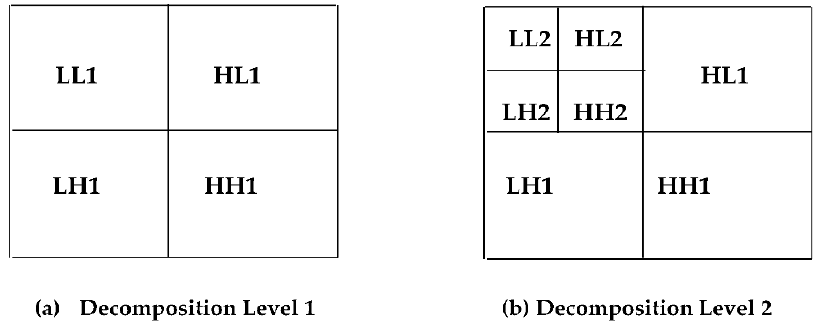
Figure 3. 2D DWT for two levels.